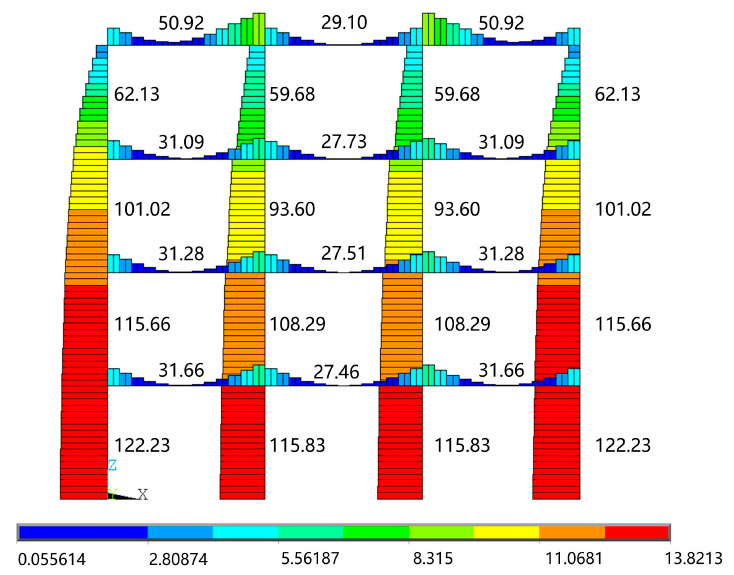
Figure 4. The results of the importance analysis of the frame by finite element method, which were calculated according to the procedure illustrated in Figure 2 above.